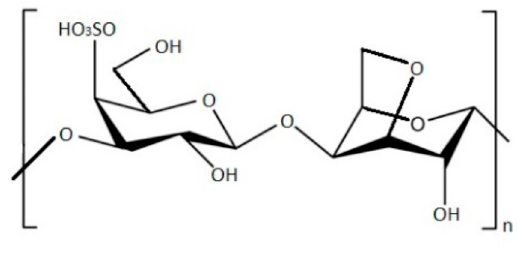
Figure 2. Chemical structure of κ -carrageenan.